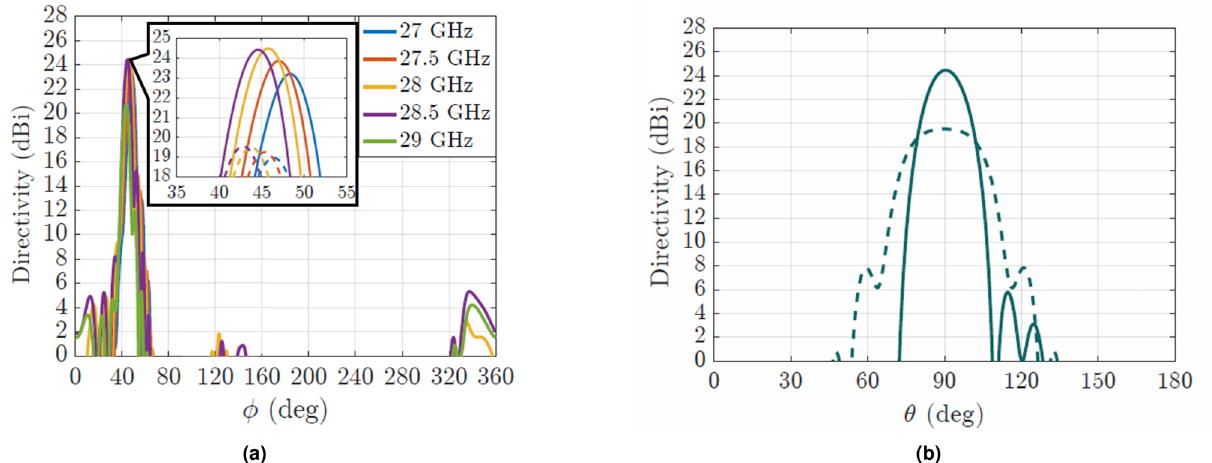
Figure 8. ( a ) Simulated directivity of the proposed array in the H-plane for different frequencies. In the inset, a comparison is made between the single antenna (dashed lines) and the designed array (solid lines). ( b ) Simulated directivity in the E-plane of the designed array at the central frequency of 28 GHz (solid line) compared to the single antenna also at the same frequency (dashed